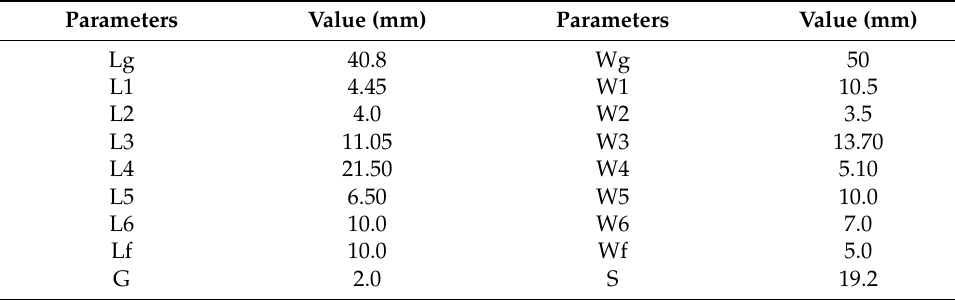
Figure 2. Reflection coefficient S 11 of the proposed triband antenna. Table 1. Parameters of the proposed triband antenna.